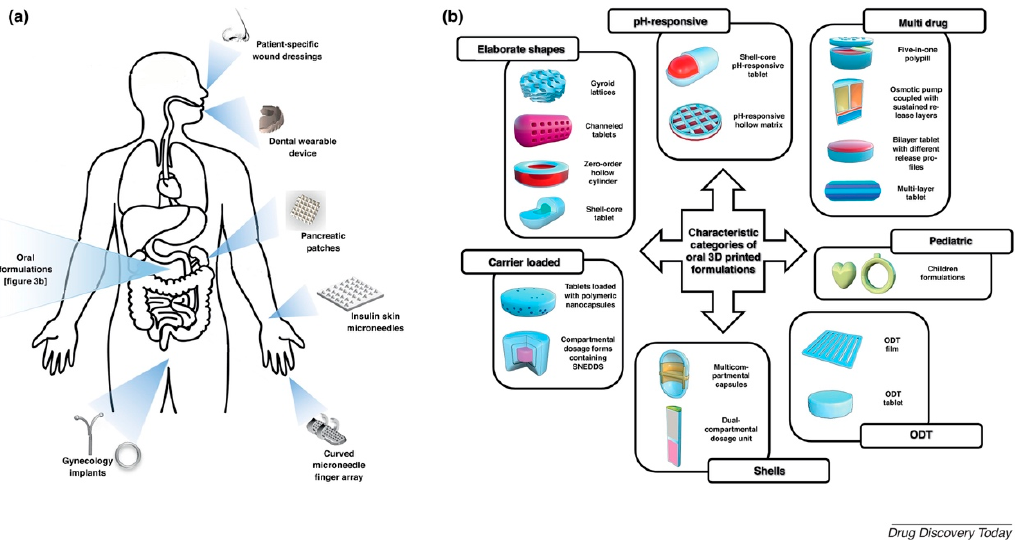
Figure 1. ( a ) Diversity of 3D-printed formulations and administration routes. ( b ) Variety of 3D- printed, orally administered solid dosage forms. Reprinted from [34], copyright 2018, with permission from Elsevier.